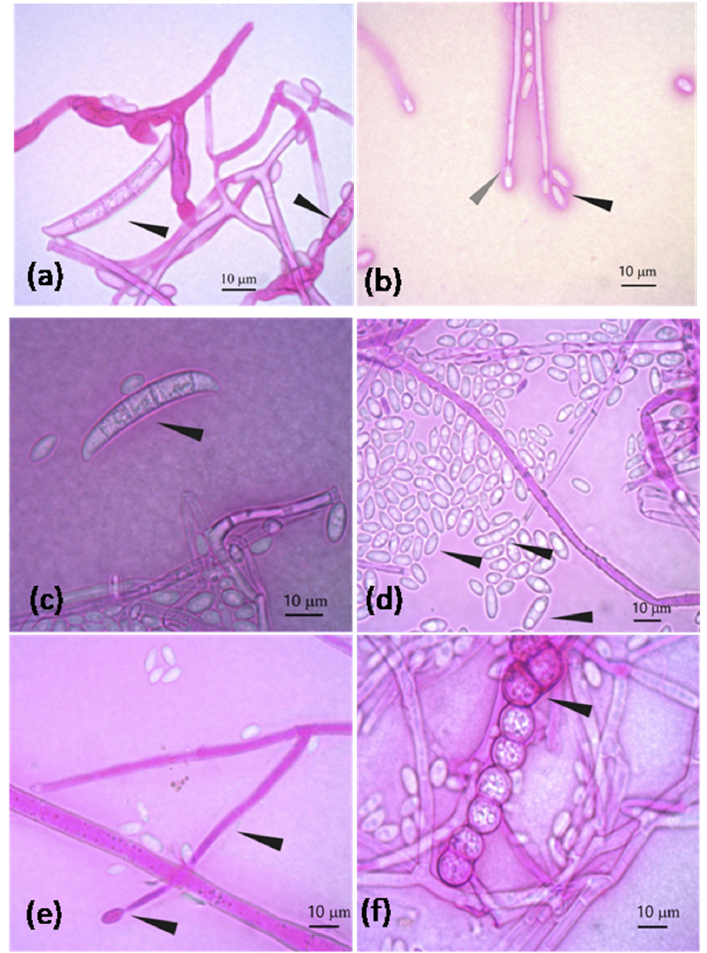
Figure 4. F. oxysporum characteristics: ( a ) Banana-shaped macroconidia transversely septated and macroconidia in formation; ( b ) Oval and elongated microconidia (black arrowhead) and elongated conidiophore in conidiogenesis at the end (gray arrowhead) (note: terminal clamidospores were not observed in ( b )). F. equiseti characteristics: ( c ) Banana-shaped macroconidia and transversely septated; ( d ) Oval and elongated microconidia; ( e ) Elongated mono-phialide with a transverse septum and conidiogenesis at the end; ( f ) Chain of verrucous clamidospores.